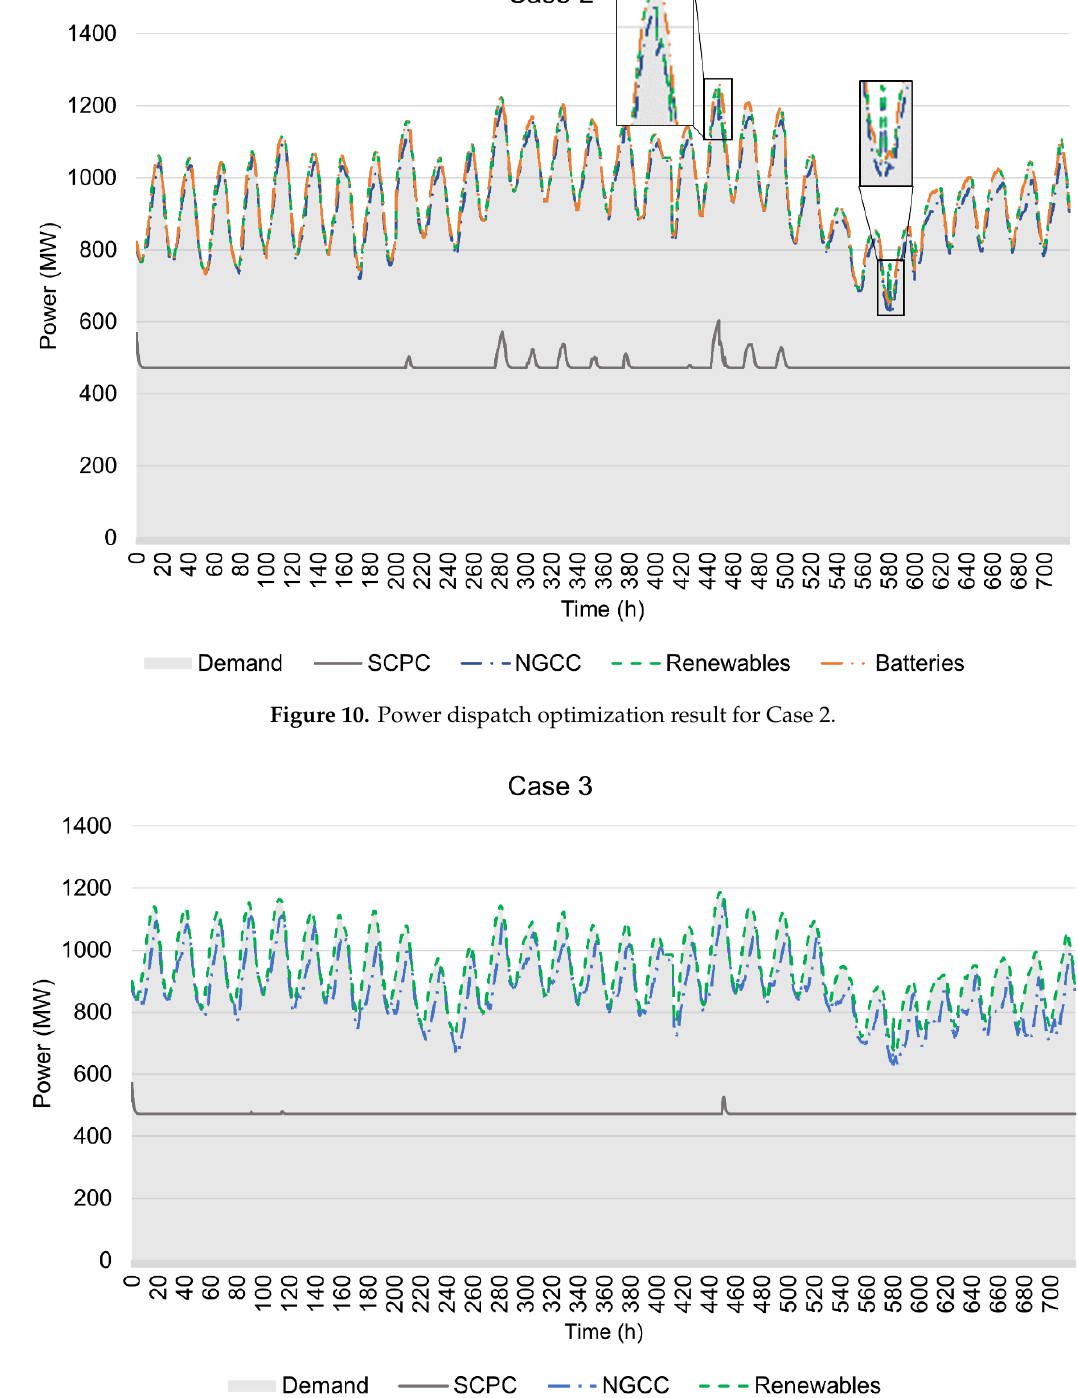
Figure 11. Power dispatch optimization result for Case 3.